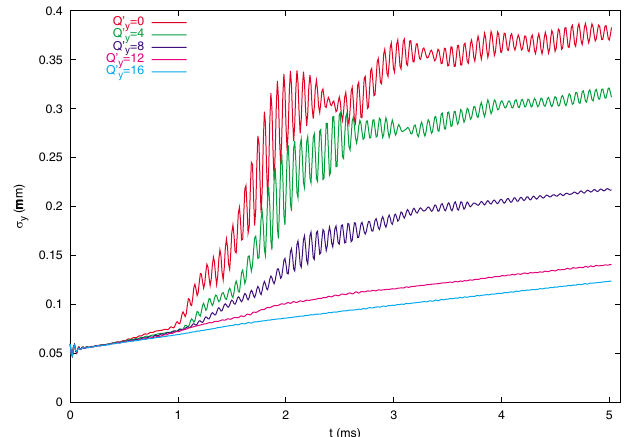
FIG. 40. (Color) Evolution of the LHC vertical beam size at injection versus normalized product of turn number and electron density, simulated by PEHTS , for various densities and synchro- tron tunes, keeping their ratio constant [88].